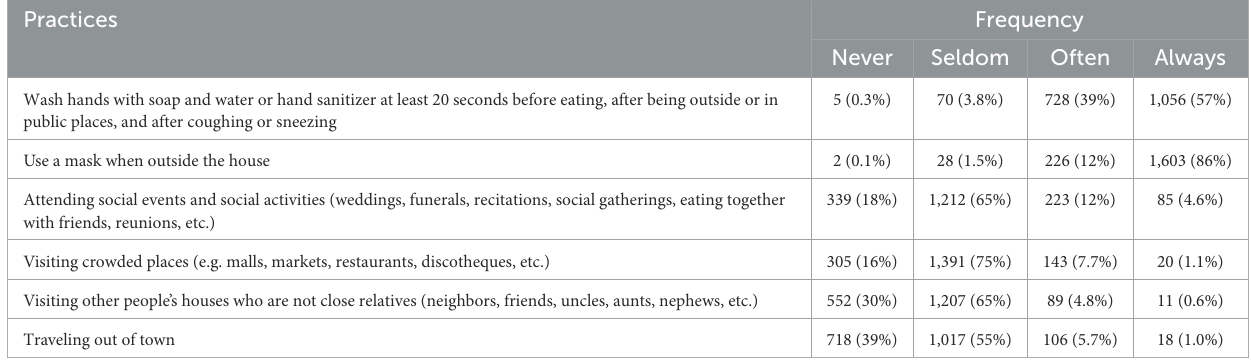
TABLE 4 Practices after the COVID-19 delta variant wave in